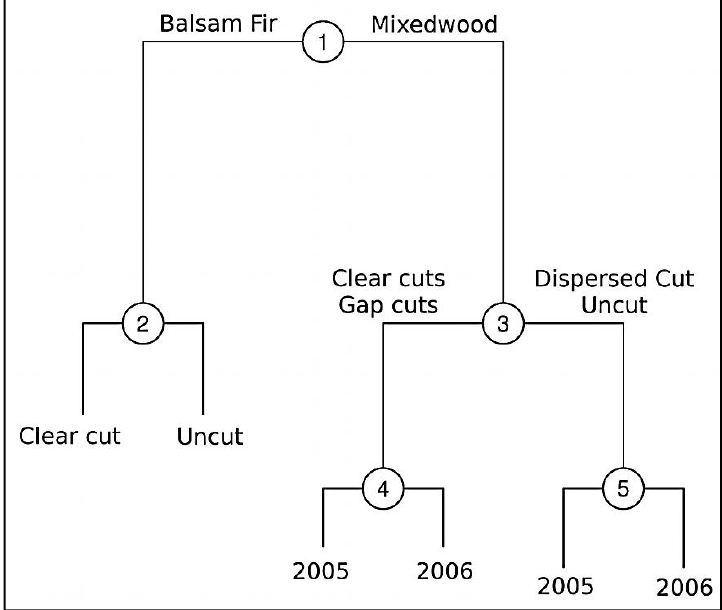
Figure 6. Multivariate regression tree of ground beetles assemblages following clear cut and partial harvesting of boreal mixedwood stands. Balsam fir data were collected in older forest stands dating from a fire in 1760 that were later affected by a spruce budworm outbreak that occurred in 1970–1987.